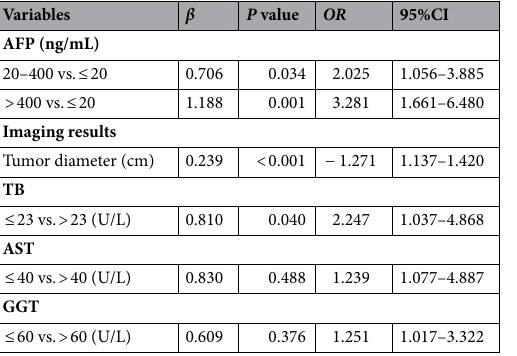
Table 4. Multivariate Logistic regression analysis of MVI presence based on preoperative data in HCC patients. AFP α-fetoprotein, TB total bilirubin, AST aspartate aminotransferase, GGT γ-glutamyl transpeptidase.